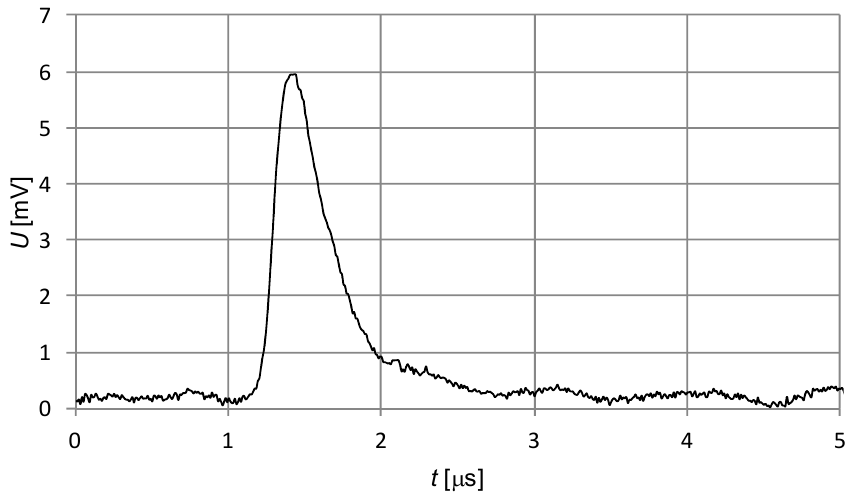
Figure 7. The pulse generated in the spark gap used to calibrate the system of two sensors.